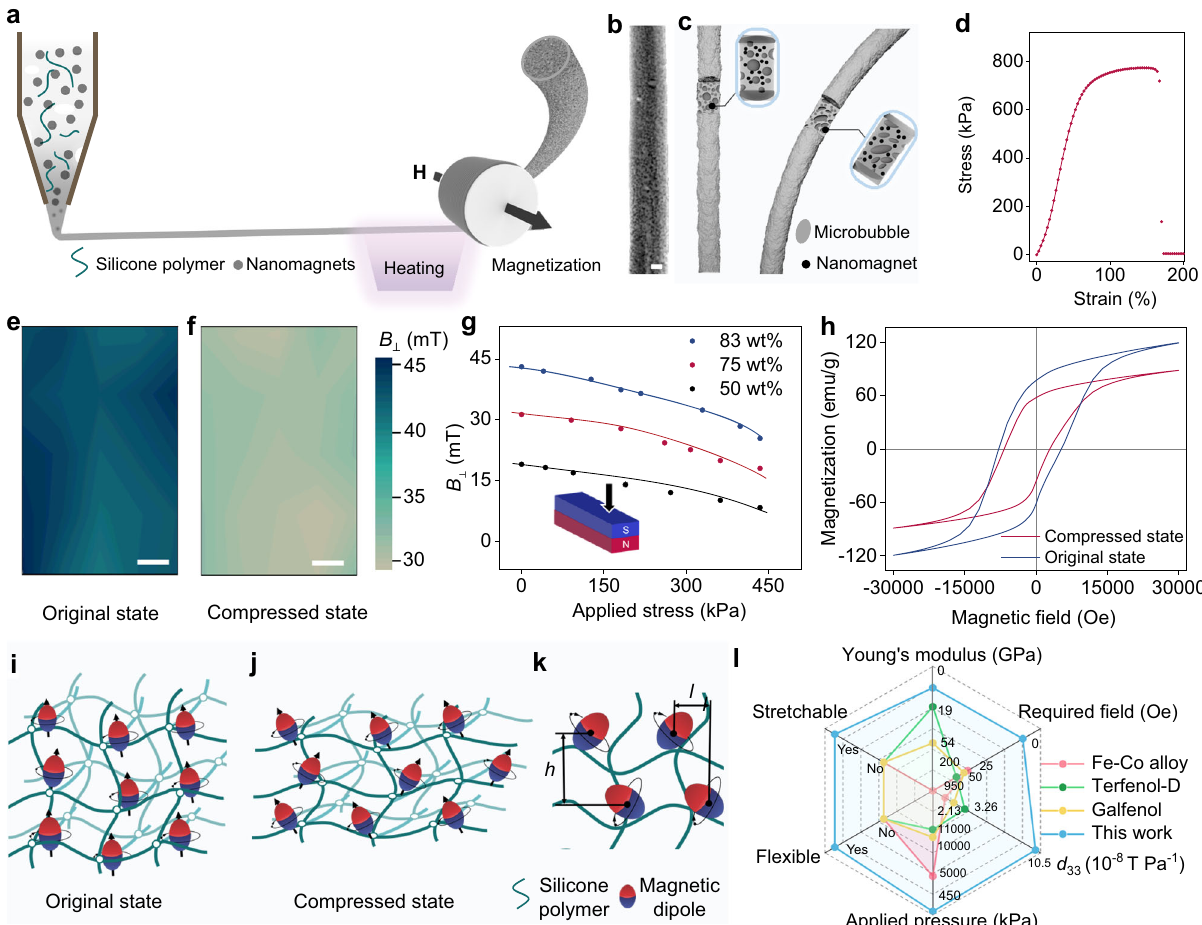
Fig. 1 The magnetoelastic effect in soft fi bers. a Schematic of the fabrication process of the soft magnetic fi bers. b Micro-CT image and c Schematics of the soft magnetic fi ber. Scale bar: 0.4 mm. d Stress – strain curves of the soft magnetic fi bers with 83 wt% magnetic concentration. e , f Vertical magnetic fl ux density ( Δ B fi ber on south pole surface in the original state ( e ) and under a compressed pressure of 300 kPa ( f ). Scale ⊥ ) mapping of the soft magnetic bars: 0.24 mm. g Magnetic fi eld variation of the soft magnetic fi ber under applied stress on the south pole surface. h Magnetic hysteresis loop of the soft magnetic fi ber in original state and in compressed state. i , j Schematics of the magnetic dipole distribution in soft magnetic fi ber of initial state ( i ) and compressed state ( j ). k Schematic of the wavy chain model. l Performance comparison of the soft magnetic fi bers with rigid metal